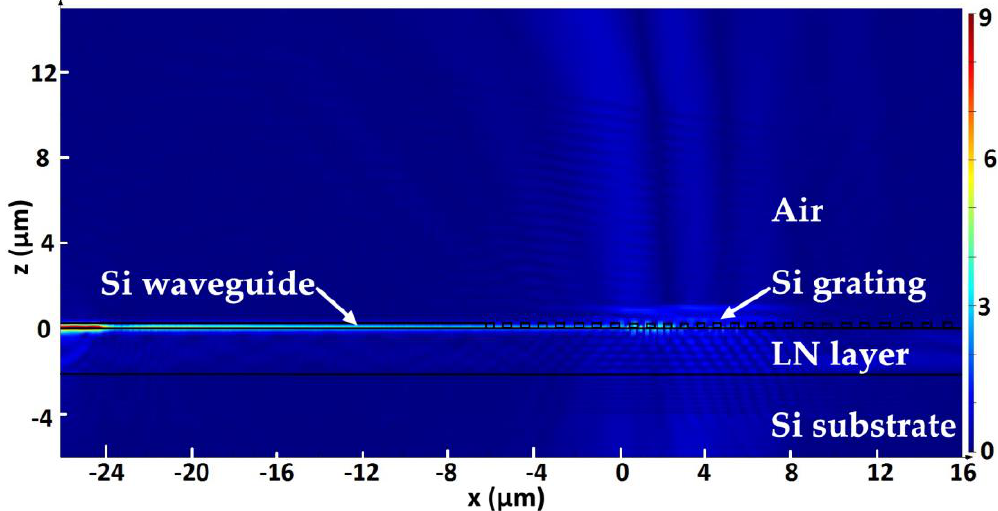
Figure 8. Electric field distribution of the optical wave in the simulation region, in which the optimal values of T = 2.1 μm Lx = 3.5 μm, Ly = 0 μm, θ = 8°, Λ = 0.64 μm, DC = 0.829, and λ = 1.55 μm were employed.